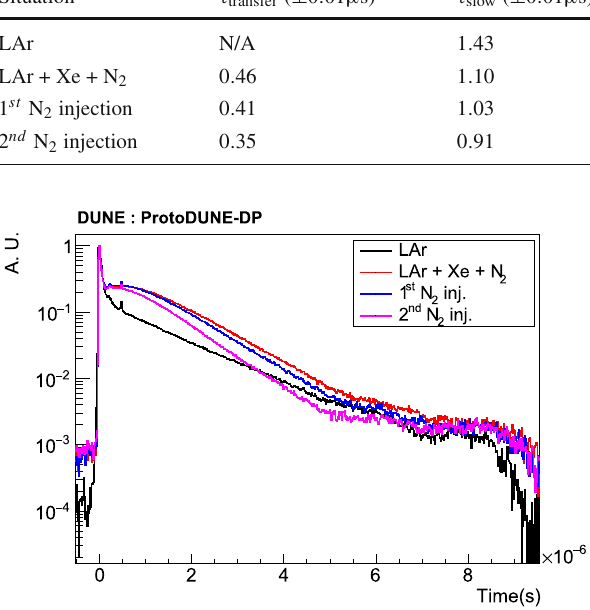
Fig. 28 Top panel: average collected S1 charge per PMT as a function of the track-PMT distance for the different doping concentrations. For each data-set, an exponential fit is performed (see results in Table 9). Bottom panel: ratios between the data shown in the top panel. Each data-set is fitted with an exponential function